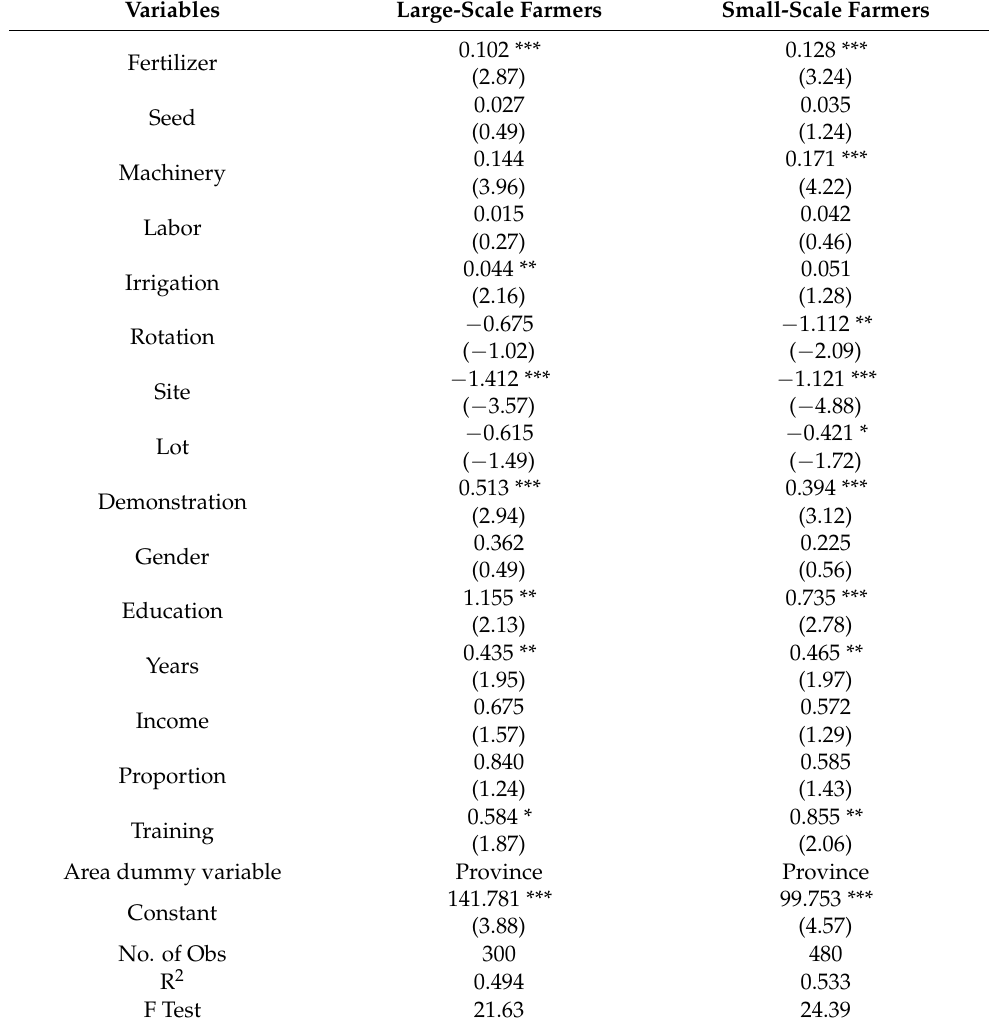
Table 4. OLS regression results of influencing factors on wheat